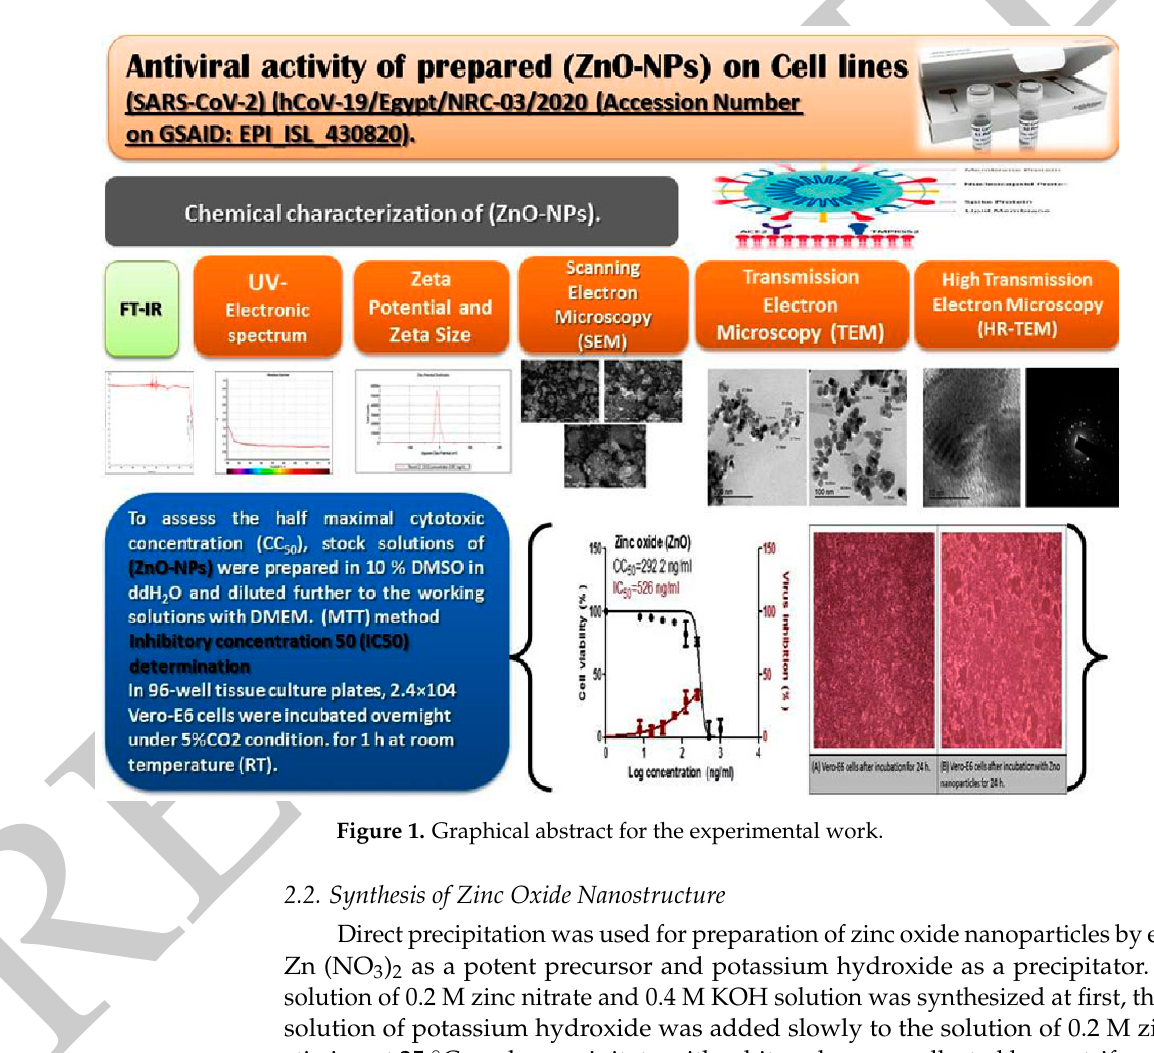
Figure 1. Graphical abstract for the experimental work.